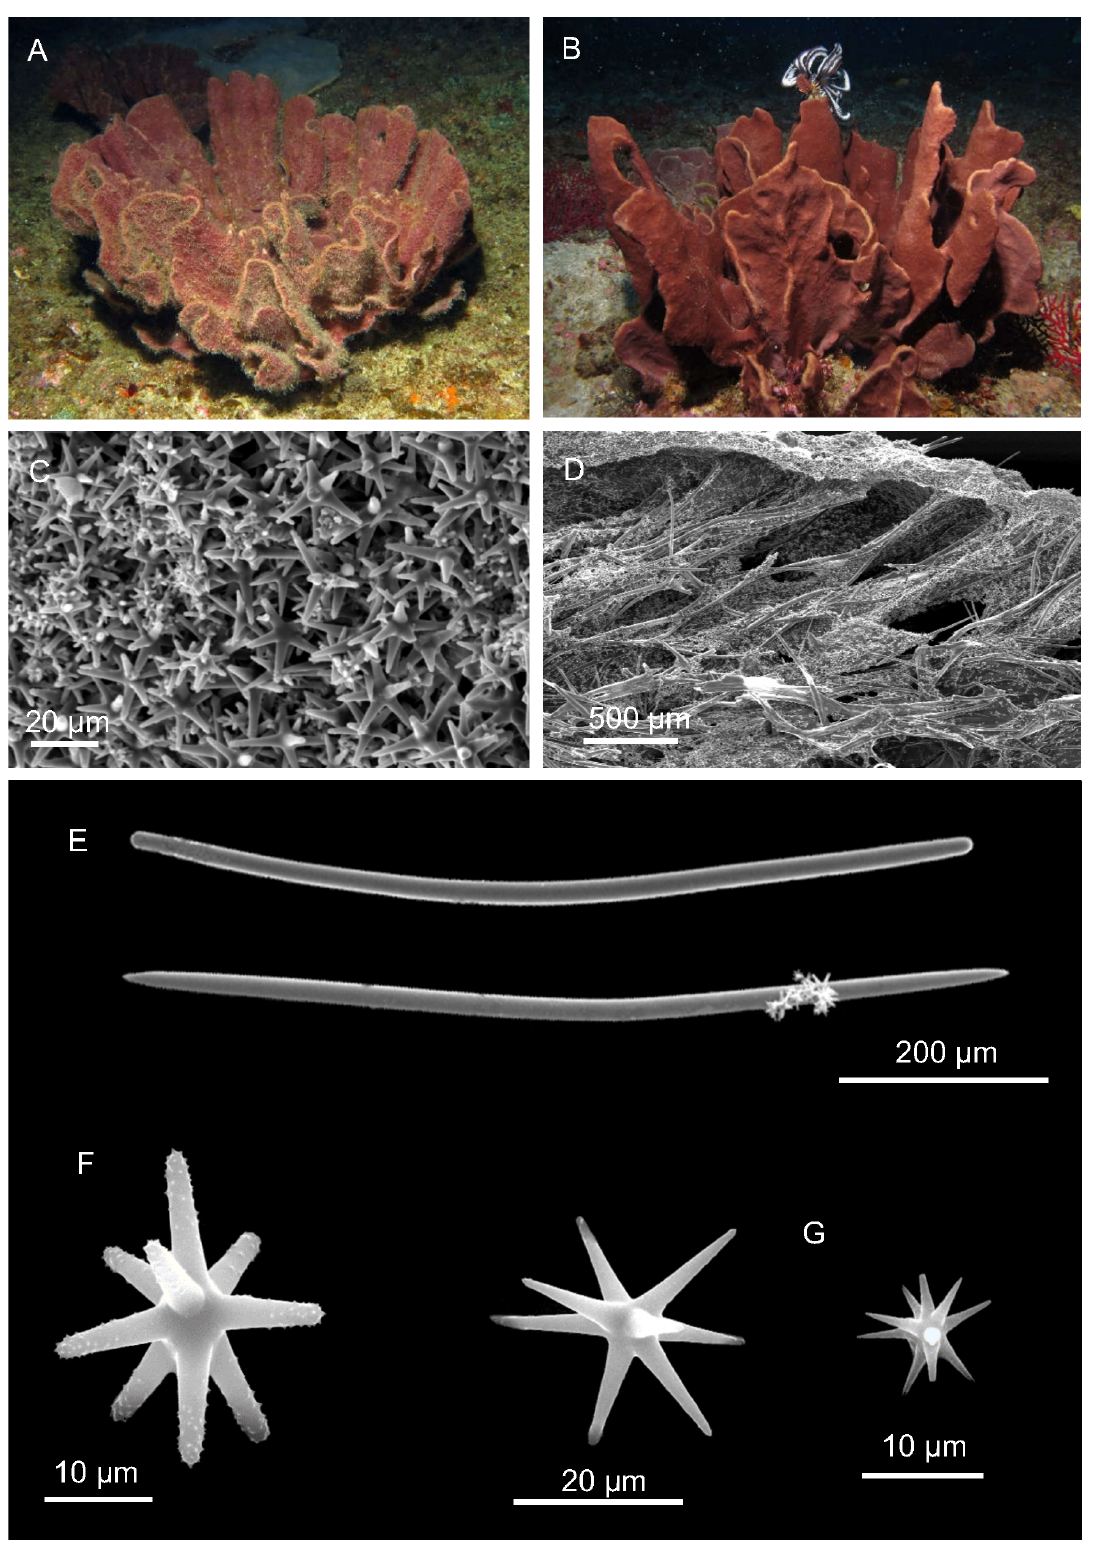
Fig. 27. Hemiasterella complicata Topsent, 1919. A . The specimen PO20 in situ . B . The specimen IMG 516. C . Ectosome constituted by densely packed euasters (SEM). D . Choanosomal skeleton (SEM). E . Strongyloxea and oxea. F . Strongylaster. G . Smooth